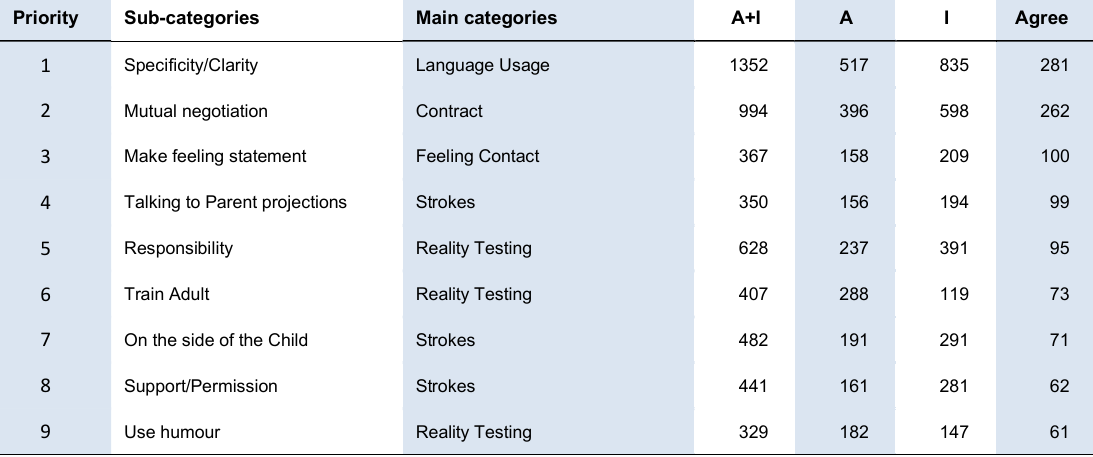
Table 3: Ranking of the frequency of the assessors’ individual and matching codings of the sub-categories. Priority 1–9